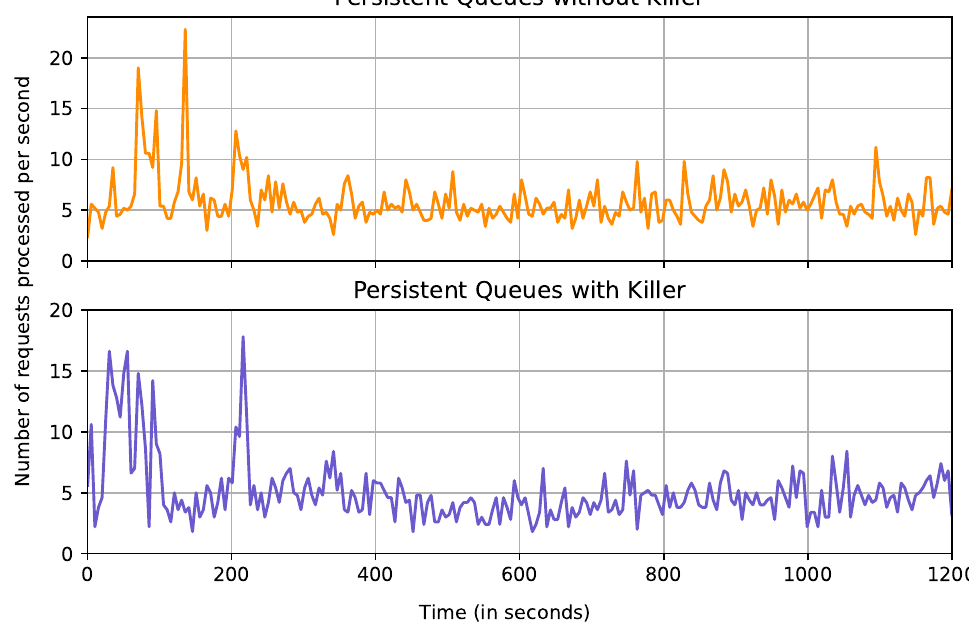
Figure 14. Results obtained when measuring the number of requests received during stress-testing over the course 1200 s without (top) and with (bottom) the killer deployed. The number of requests received is measured and reset every 5 s. The plot shows the average number of requests per second over each 5 s interval.